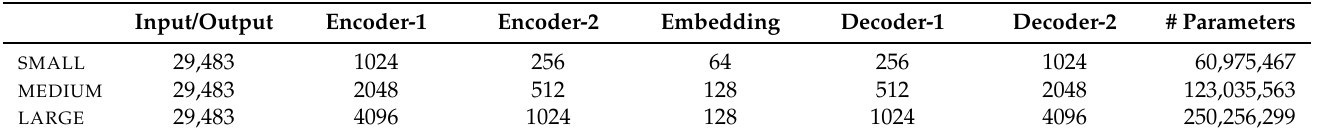
Table 4. Configuration of label autoencoders in our experiments.